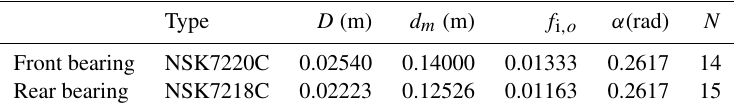
Figure 9. Simulated and measured results. (a) Bearing preload. (b) T1 (Front bearing). (c) T2 (Rear bearing). (d) Thermal displacement. Table 1. Ball bearings